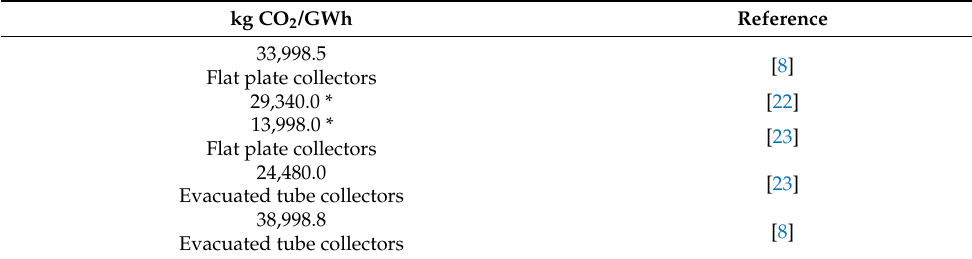
Table 5. CO 2 emissions (DHW